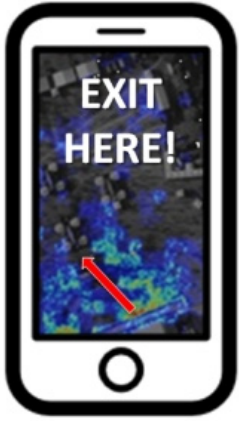
Figure 4. Schematic representation of an emergency smartphone app. The crowd density is visualized in the background. The fastest escape route is emphasized with a red